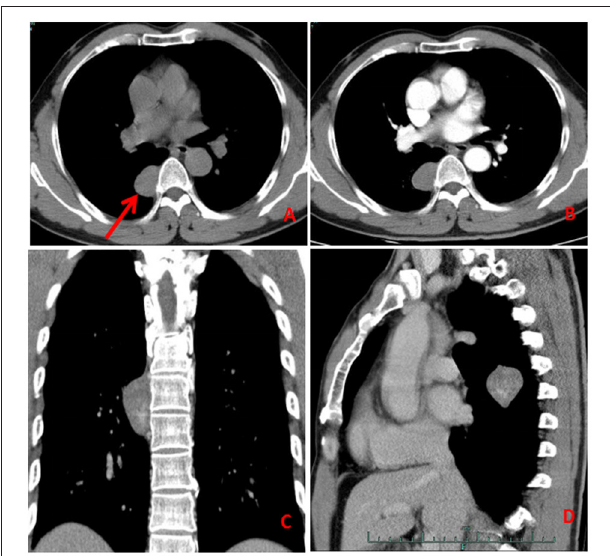
FIGURE 1 | Computed tomography ( A : axial, C : coronal, D : sagittal) of the chest showed a mass in the posterior mediastinum (red arrow). The enhancement scan (B) was uneven and slightly enhanced.